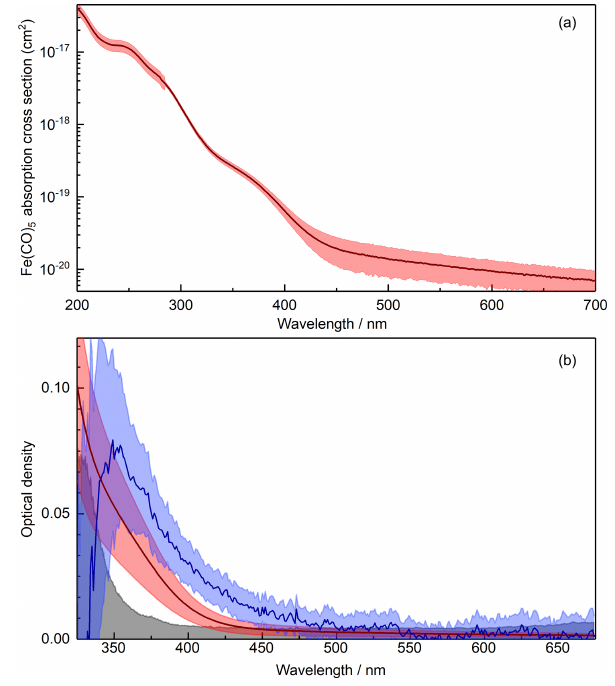
Figure 4. (a) Measured Fe ( CO ) 5 absorption cross section (cm 2 ) with experimental uncertainty indicated by red shading. (b) Iron oxide particle extinction with the precursor spectrum removed (blue line) and experimental uncertainty indicated by light blue shading. Also shown is the spectrum for the Fe ( CO ) 5 present in the absorp- tion cell (red line), with the experimental uncertainty indicated by red shading. The detection limit for the experiment is shown with the black line and shaded region. Note the different wavelength ranges in each panel.